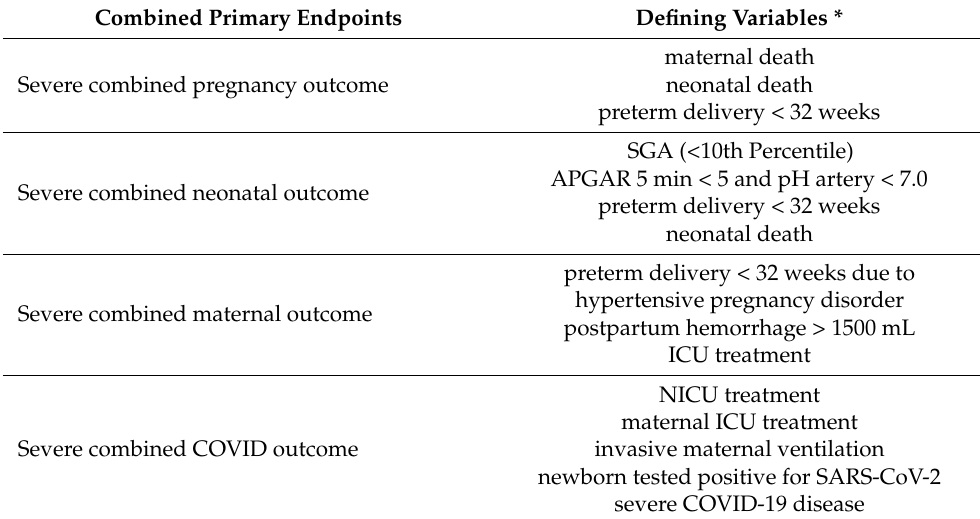
Table 1. Definition of the Combined Primary Endpoints: Severe combined pregnancy outcome, Severe combined neonatal outcome, Severe combined maternal outcome, Severe combined COVID outcome. Combined Primary Endpoints Defining Variables * Severe combined pregnancy outcome Severe combined neonatal outcome Severe combined maternal outcome Severe combined COVID outcome